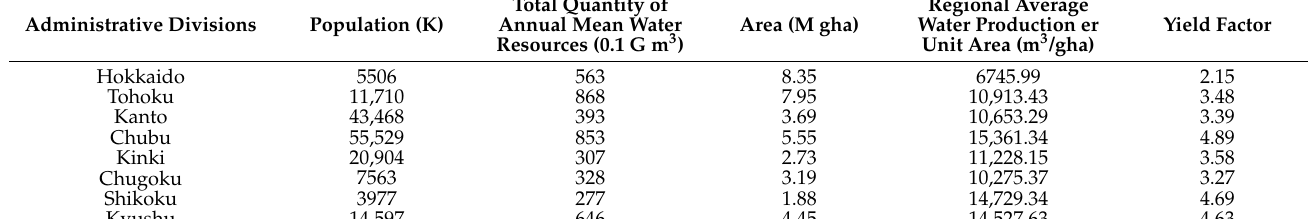
Table 1. Basic overview of different administrative divisions in Japan.